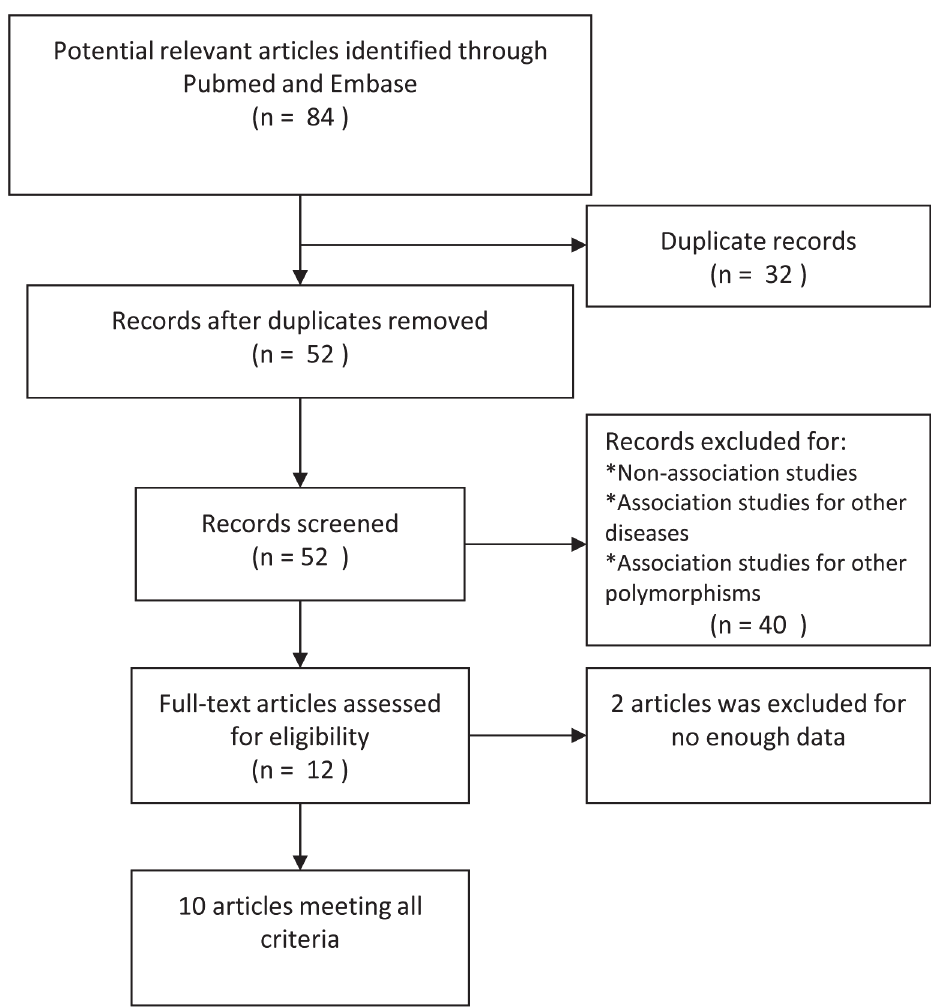
Fig 1. Flow of study indentification, inclusion and